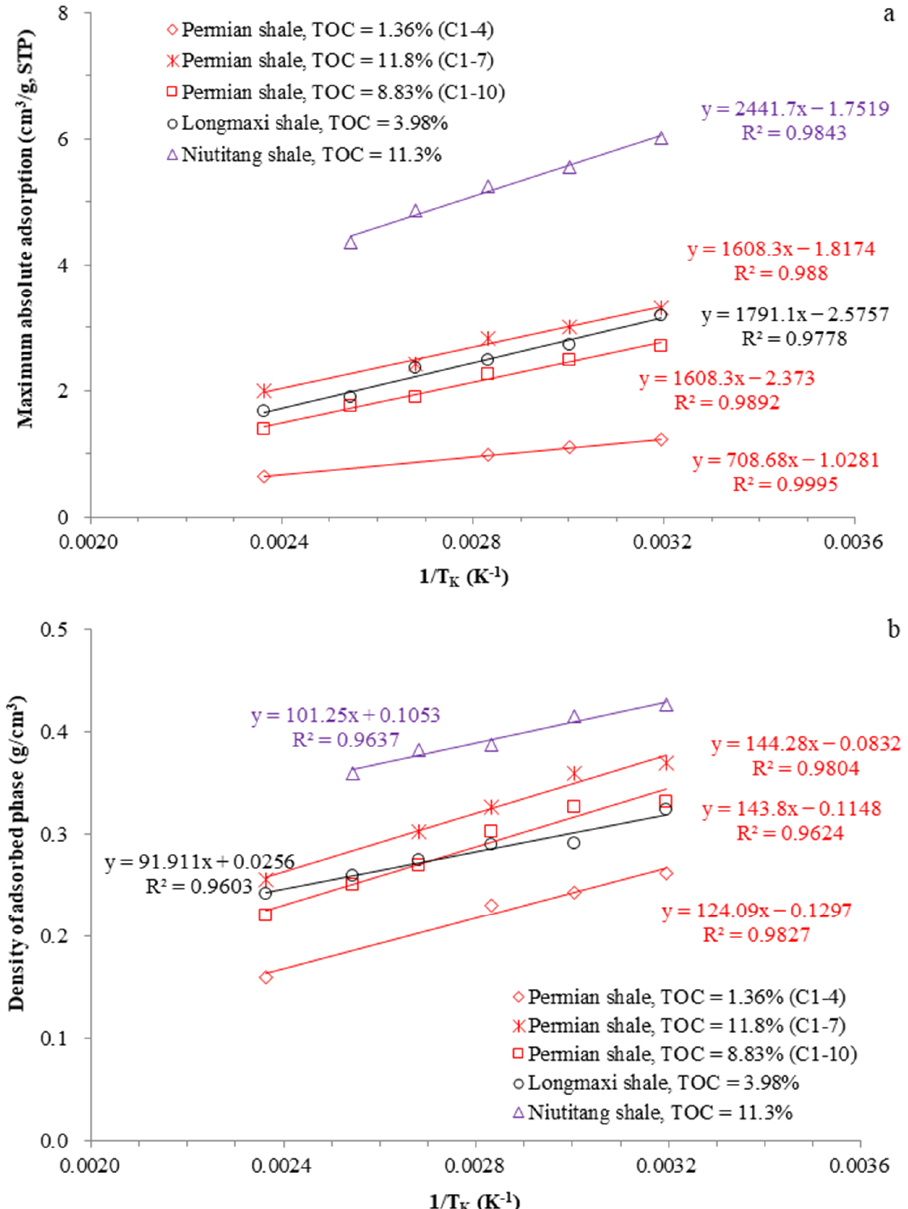
Figure 9. Plots showing the relationships between the reciprocal of the Kelvin temperature with the maximum absolute adsorption capacity ( a ) and the density of adsorbed phase ( b ) for shales. (The Longmaxi and Niutitang shales are from Pan et al. [8] and Li et al. [14], respectively).